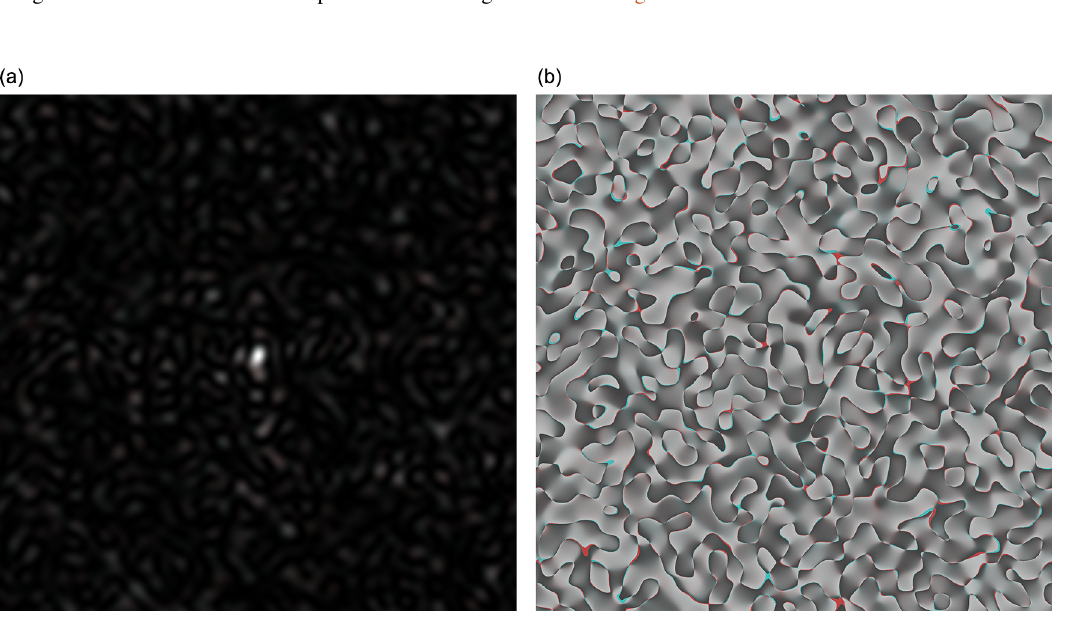
Figure 2. Coloured GB speckles, generated for genes #1, #2 and #3: (a) Coloured speckle-pattern for 2D intensity distribution, (b) Coloured speckle-pattern for 2D phase